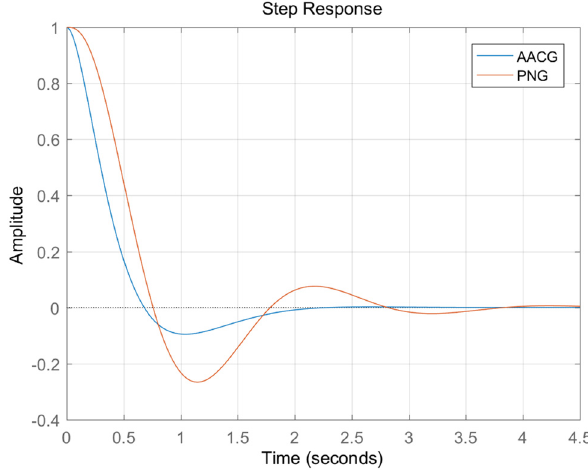
Figure 8: Unit step response of closed - loop system Φ ( s ) .